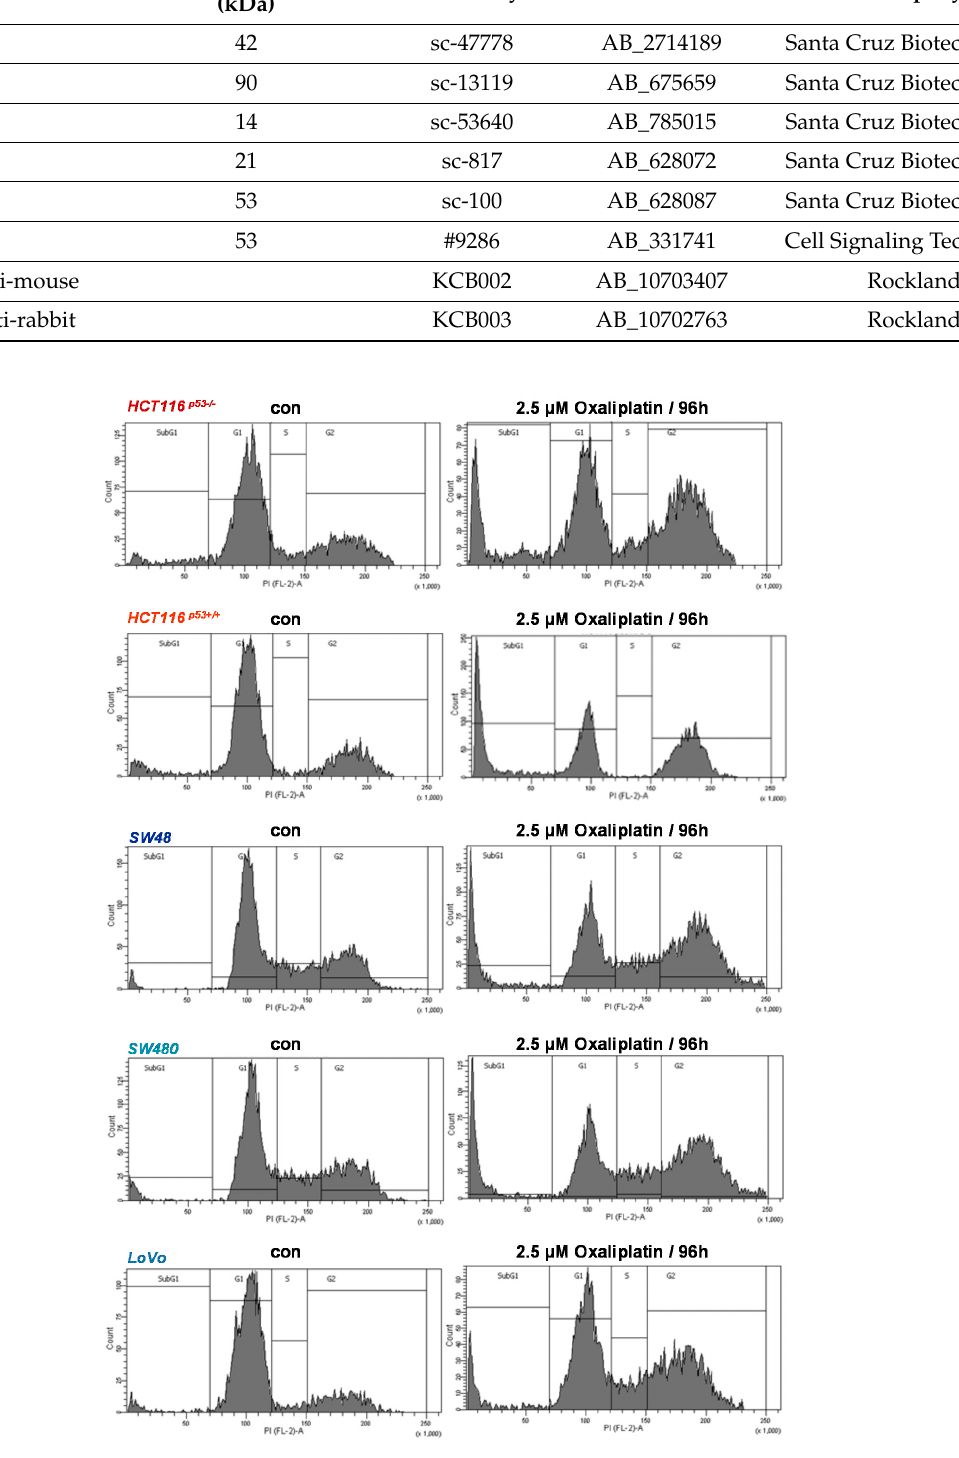
Figure A1. Cell death and cell cycle distribution were measured by flow cytometry 96 h upon exposure to oxaliplatin in PI-stained CRC cells. Representative histograms were shown for untreated cells (con) and cells exposed to 2.5 µM oxaliplatin.